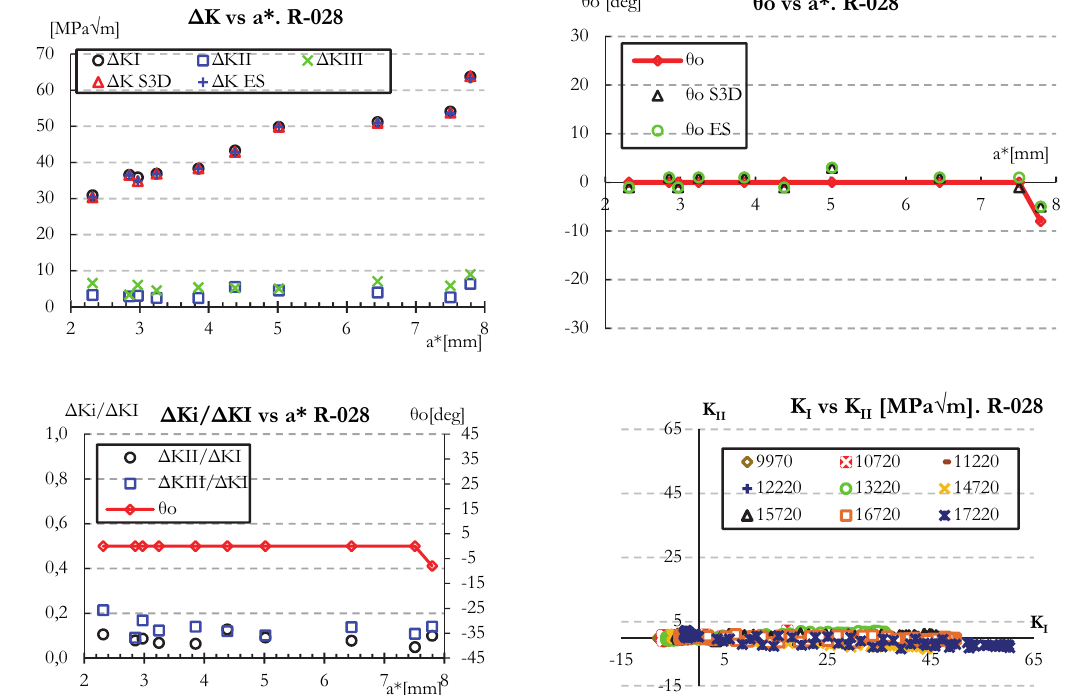
Figure 5: Crack tip parameters measured and calculated for specimen R-028, single alternated tension 45kN max.